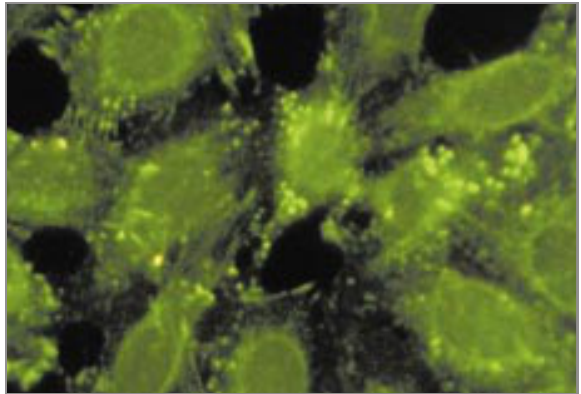
Figura 15 – Citoplasmático fibrilar segmentar